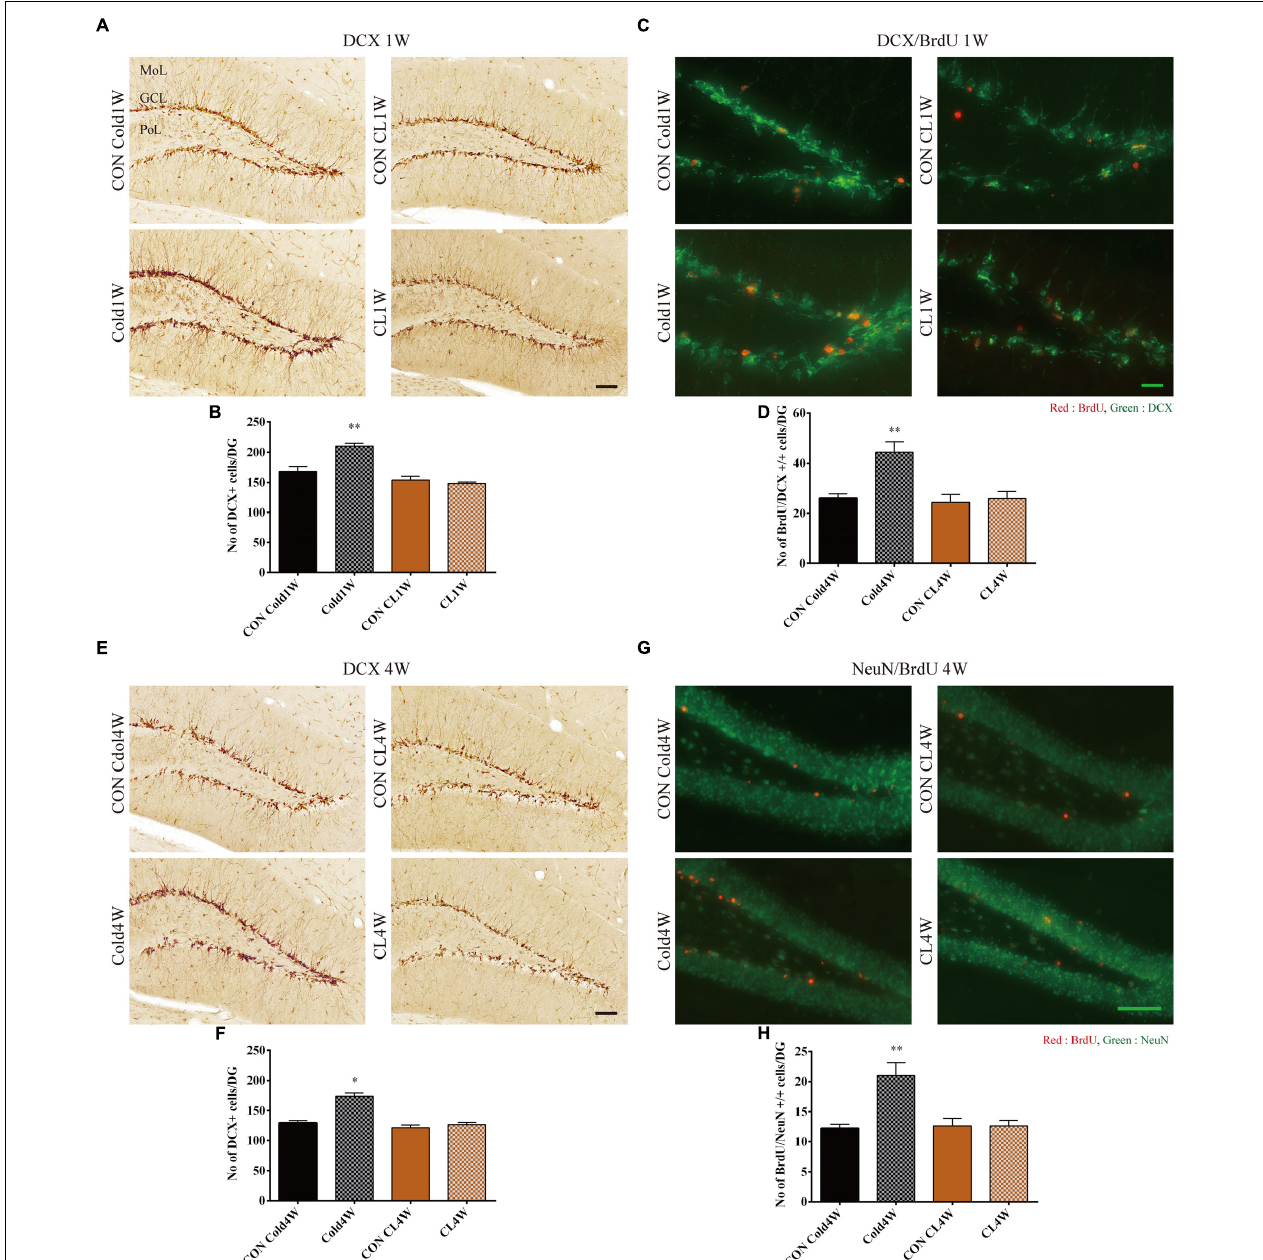
FIGURE 4 | Effects of cold challenge or CL 316,243 treatment for 1 week or 4 weeks on DCX immunoreactive neuroblasts, 1 week on differentiation of proliferating cells into DCX immunoreactive neuroblasts and for 4 weeks on integration of proliferating cells into NeuN immunoreactive mature neurons in the dentate gyrus. Note that DCX immunoreactive neuroblasts in the Cold1W and Cold4W groups are numerous and have complex dendrites when compared with that in the CON Cold1W and CON Cold4W groups, respectively (A , E) . However, in the CL1W and CL4W groups, the distribution pattern and the number of DCX immunoreactive neuroblasts are similar to that in the CON CL1W and CON CL4W groups (A , E) . BrdU and DCX double positive cells are abundant in the Cold1W group when compared with that in the CON Cold1W group (C) . Similarly, BrdU and NeuN double positive cells are abundantly observed in the Cold4W group when compared with that in the CON Cold4W group (D) . However, there are no significant differences on the distribution pattern and number of BrdU and DCX double positive cells in the dentate gyrus between the CON CL1W and CL1W groups or the BrdU and NeuN double positive cells in the CON CL4W and CL4W groups (C , G) . GCL, granule cell layer; MoL, molecular layer; PoL, polymorphic layer. Quantitative analysis of DCX immunoreactive neuroblasts on the differentiation of proliferating cells into DCX immunoreactive neuroblasts (after 1 week cold exposure or CL 316,243 treatment) and on integration of proliferating cells into NeuN immunoreactive mature neurons (after 4 weeks cold exposure or CL 316,243 treatment) per section in the CON Cold1W, Cold1W, CON Cold4W, Cold4W, CON CL1W, CL1W, CON CL4W, and CL4W groups (B,D,F,H) ( n = 5 per group); ∗ indicates a significant difference when compared with the CON group ( p < 0.05); and ∗∗ indicates a significant difference when compared with the CON group ( p < 0.01). Data are shown as mean + SEM. Black scale bar = 100 µ m and green scale bar = 25 µ m.